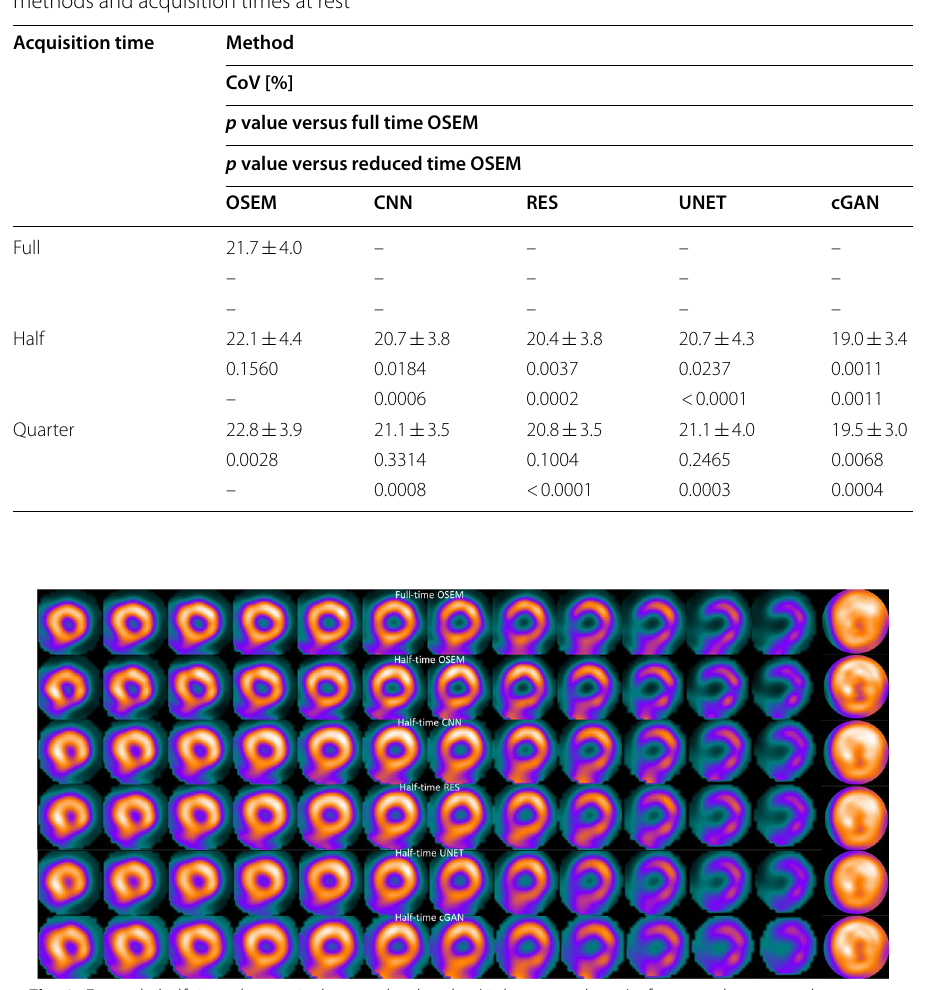
standard deviation) of myocardium counts for different ±